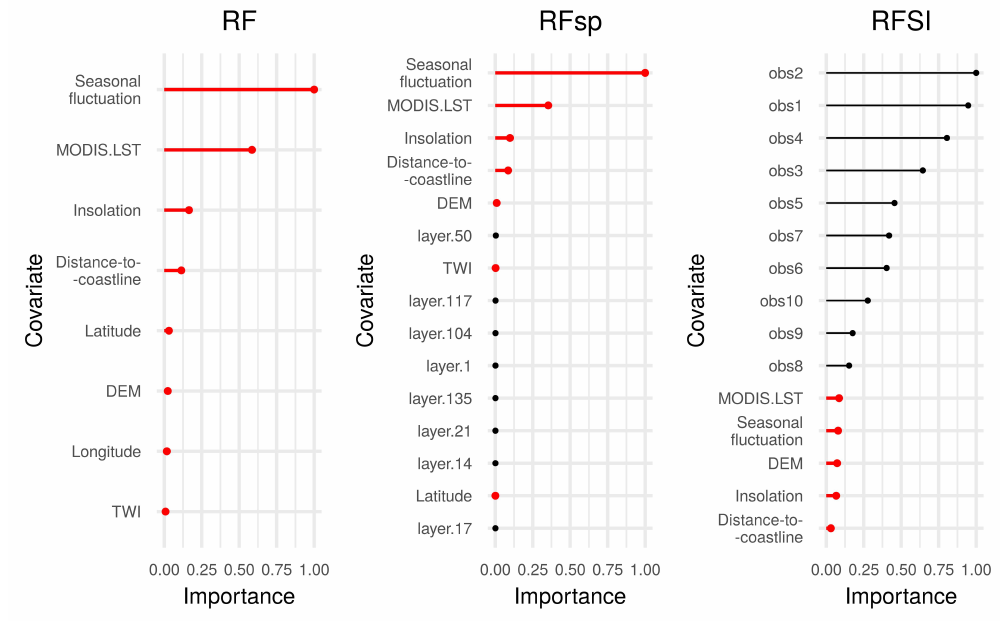
Figure 14. Covariate importance plot for RF ( left ), RFsp ( middle ) and RFSI ( right ), for the temperature case study. The importance index is scaled to a maximum of 1. The importance of environmental covariates is shown in red.